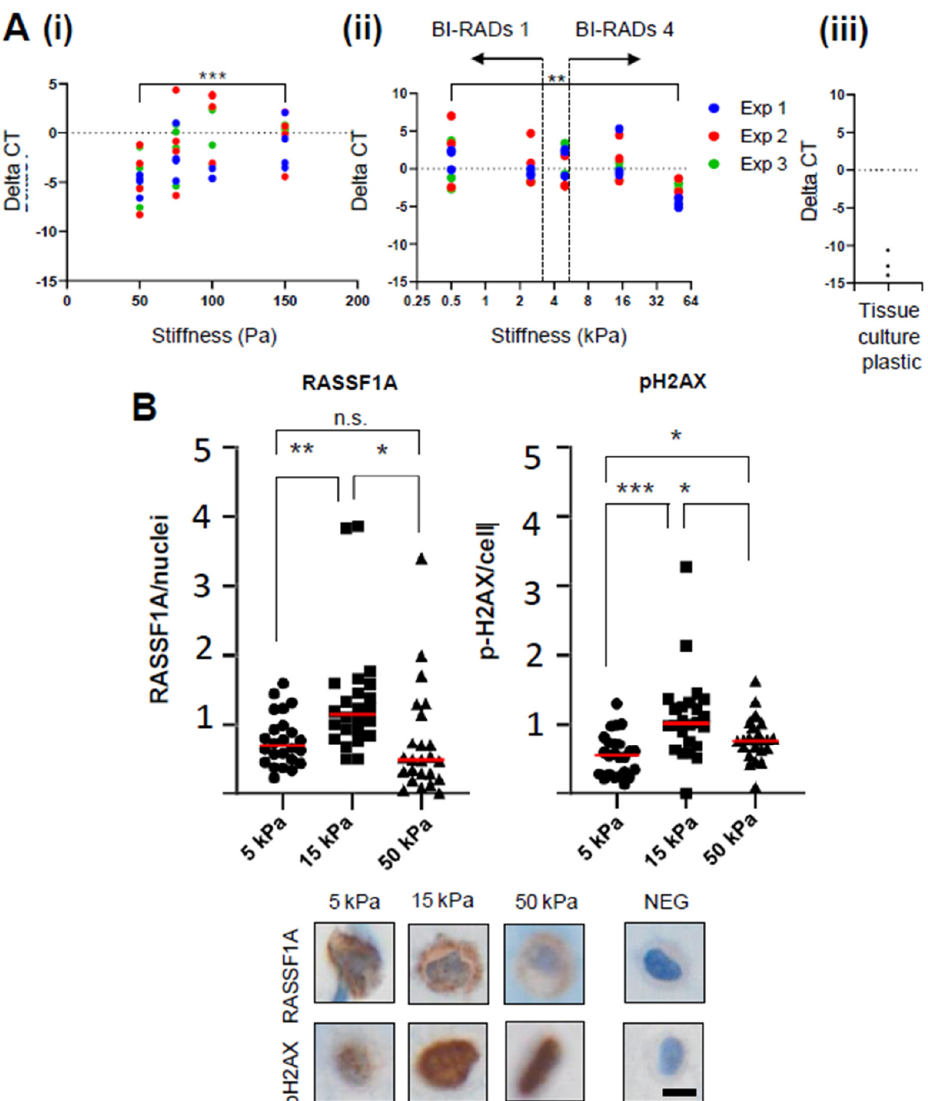
Figure 2. DCIS.com cells grown in 3D matrices of increasing stiffness display a biphasic pattern of RASSF1A gene and protein expression. ( A ). (i) 50–150 Pa achieved with Matrigel; (ii) 0.5–64 kPa achieved with GelMA, (iii) expression in DCIS.com cells grown on tissue culture plastic (>10,000 kPa). Data shown is deltaCT ( RASSF1A normalized to housekeeping gene RPL32 ) plotted against stiffness. Three independent biological replicates are shown (denoted by color). ** denotes p < 0.01, **** denotes p < 0.0001, Pearson r correlation test with Gaussian distribution, confidence interval of 95%. Overlaid ranges were derived as depicted in Figure 1C. The red dotted line indicates the upper limit of stiffness of tissues classed as BiRADs 4. BBD = stiffness associated with benign breast disease (between 64 kPa and >10,000 kPa of tissue culture plastic). ( B ) Immunohistochemistry for RASSF1A and pH2AX in formalin fixed, paraffin embedded 3D gel plugs of DCIS.com cells at increasing stiff- ness. NEG denotes the no-primary antibody control. Representative images are shown, with further images of RASSF1A, pH2AX, and NEG control at 5, 15, or 50 kPa shown in Supplementary Figures S1, S2 or S3, respectively. Cell death was not observed at either stiffness, as shown in representative images in Supplementary Figure S4. Magnification 40×, scale bar = 5 μ m. Student’s t test was used to determine significance. The Shapiro–Wilk test was performed prior to ascertain normality. For all tests used, * denotes p < 0.05 and ** denotes p < 0.01, *** denotes p < 0.001.